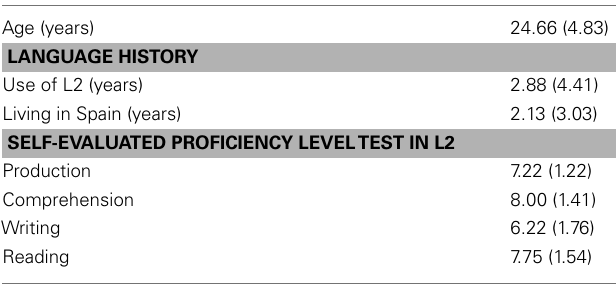
TableA1 | Language history and self-evaluated proficiency scores of the Italian–Spanish bilinguals.